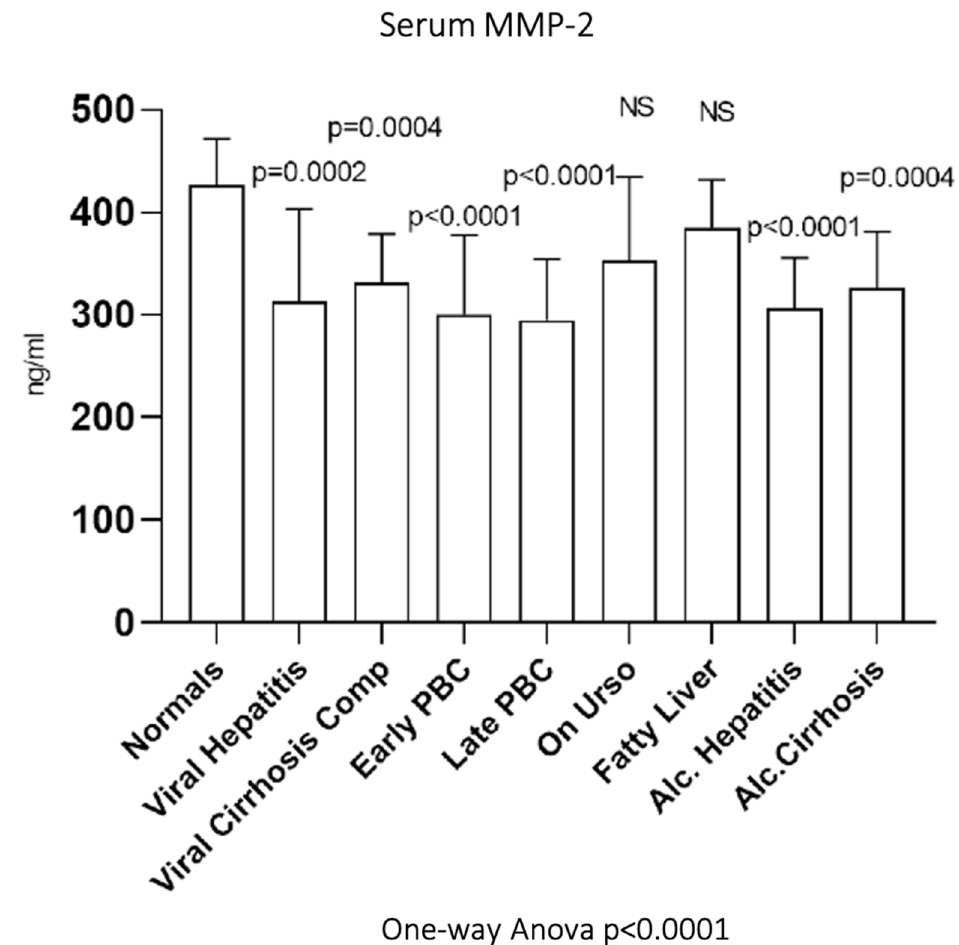
Figure 7. Serum MMP-2 in all studied groups.